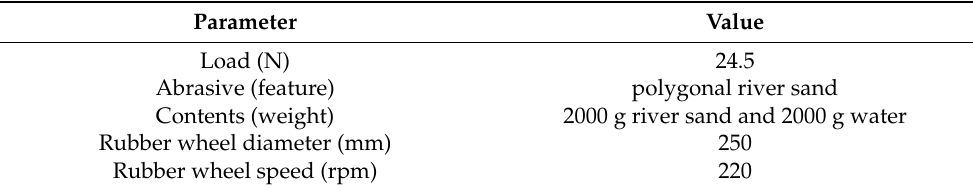
Table 3. Abrasive wear test parameters of FeB-30 wt.% Al 0.25 FeNiCoCr coating and the